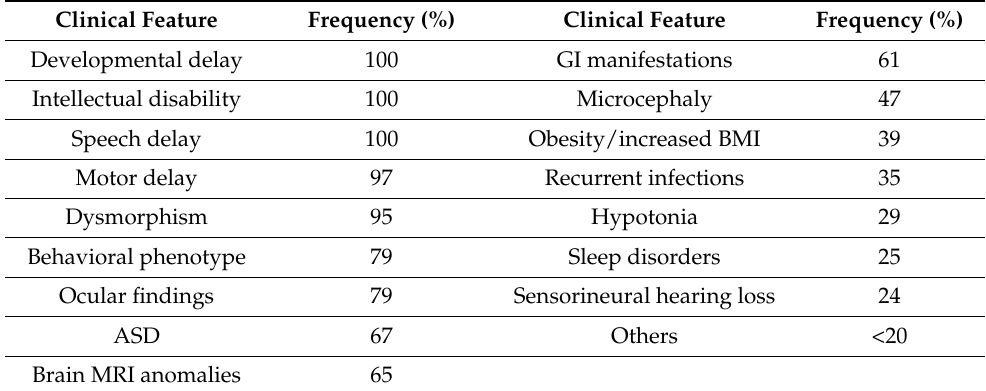
Table 1. Clinical features in order of